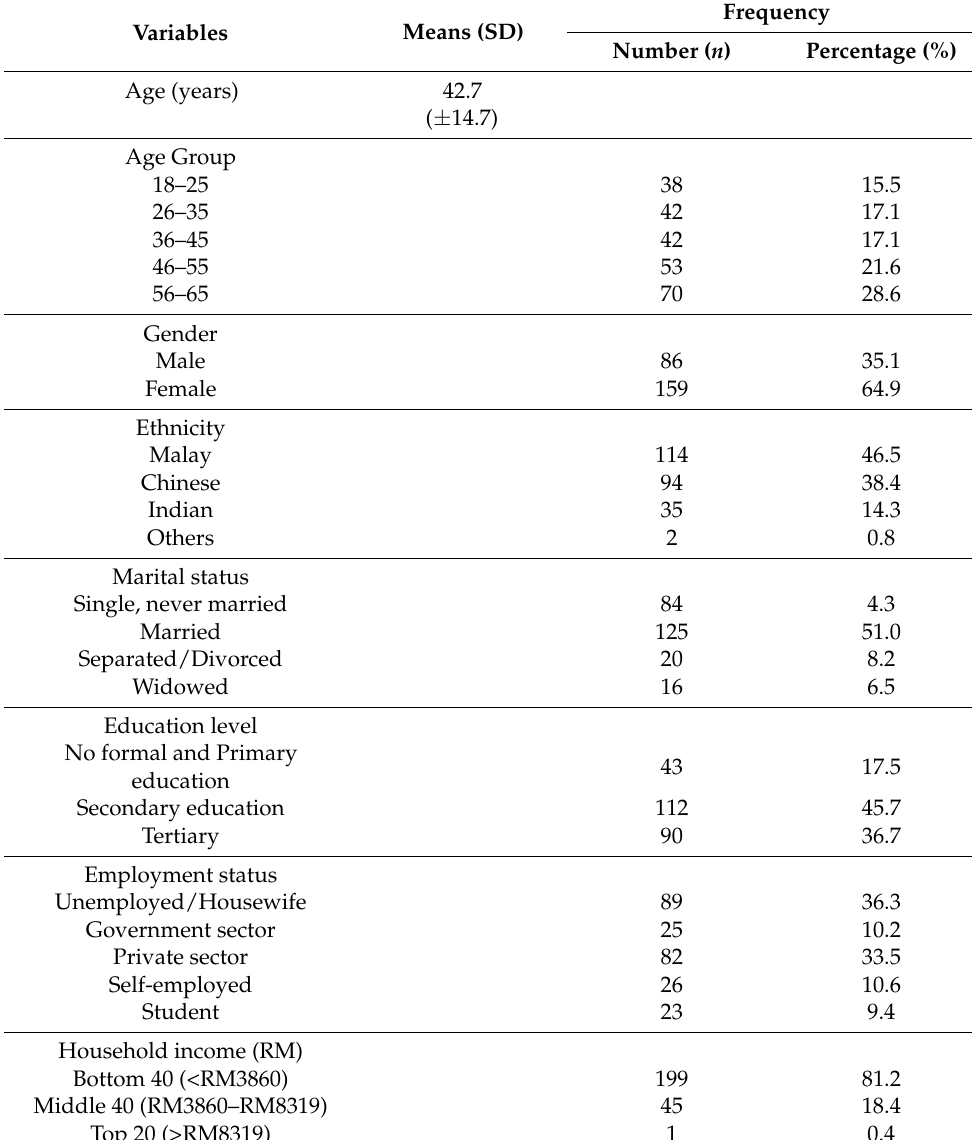
Table 1. Sociodemographic profile of the patients ( n =